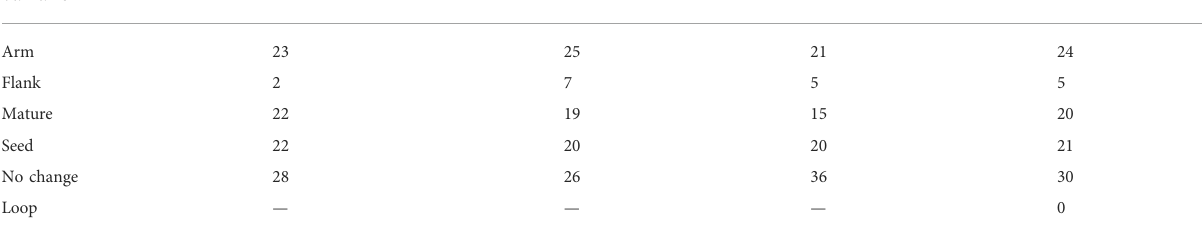
TABLE 3 Analysis of structural impacts of miRNA variants by miRVaS. Structural impact of the Centroid (n ° of variant